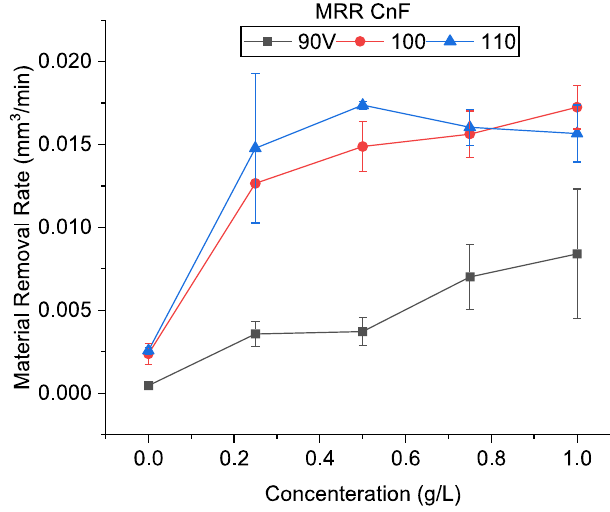
Figure 9. Material removal rate using CnF-mixed